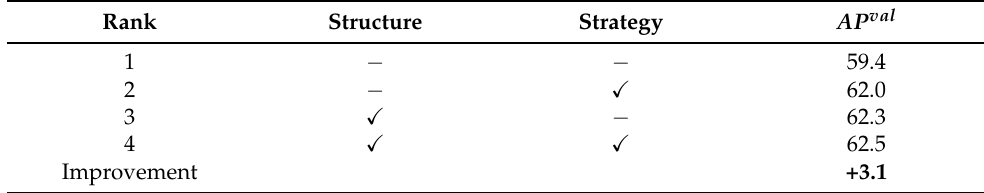
Table 9. Results of ablation experiments with improved structures and